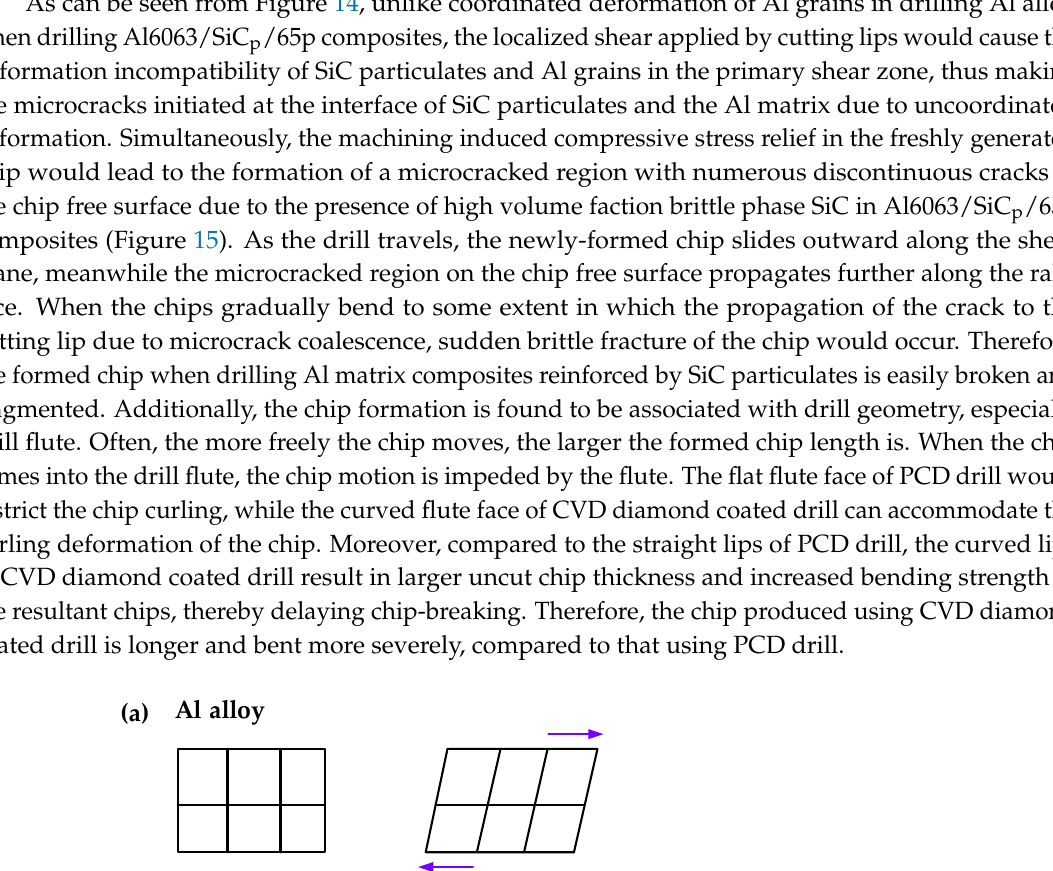
Figure 13. Schematic of chip formation in drilling of ( a ) Al alloy and ( b ) SiC p /Al composites.